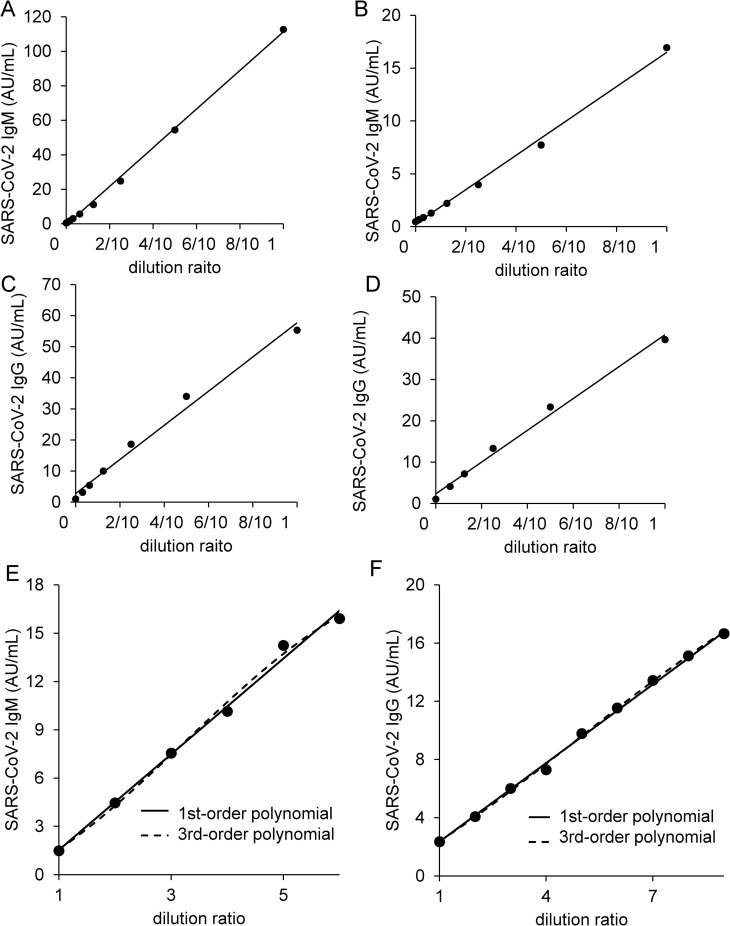
Linearity analyses of SARS-CoV-2 antibody titer.The dilution linearities of SARS-CoV-2 IgM (A, B) and SARS-CoV-2 IgG (C, D) were investigated. A sample was diluted with non-reactive serum in 5 to 8 steps; each sample was then analyzed with two replicates. The linearity studies for SARS-CoV-2 IgM (E) and SARS-CoV-2 IgG (F) were performed according to CLSI EP06-A. The sample of high antibody titer was diluted with the sample of low antibody titer in 6 to 9 steps; each sample was the analyzed with two steps.